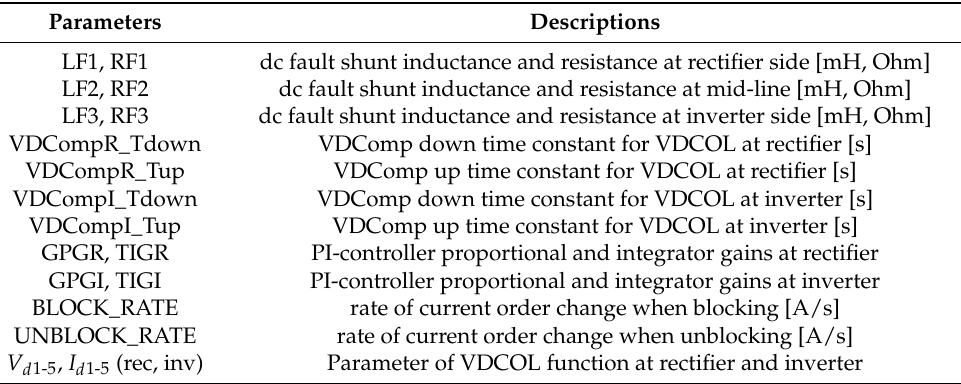
Table 3. CDC7T Parameters which can be modified by the system operators (Group B).